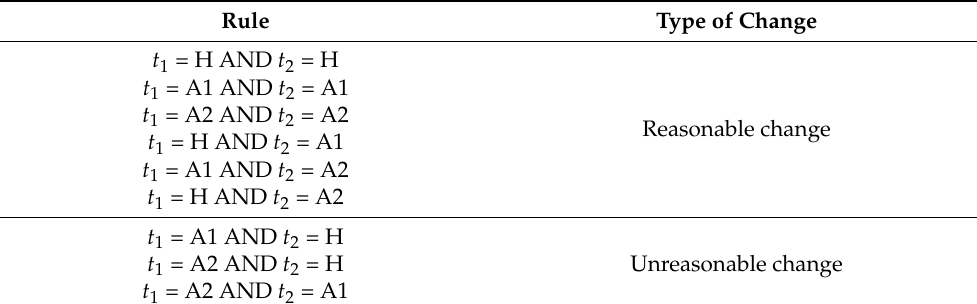
Reasonable change Unreasonable